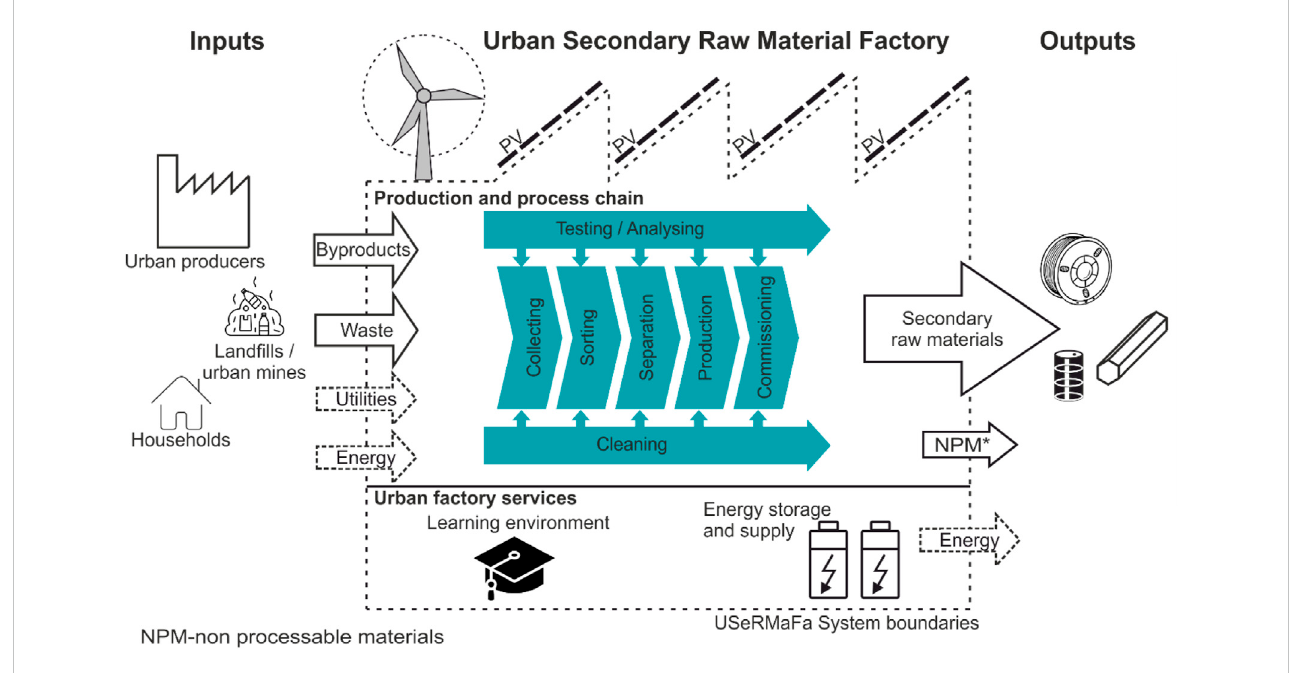
FIGURE 5 USeRMaFa characteristics and internal material fl